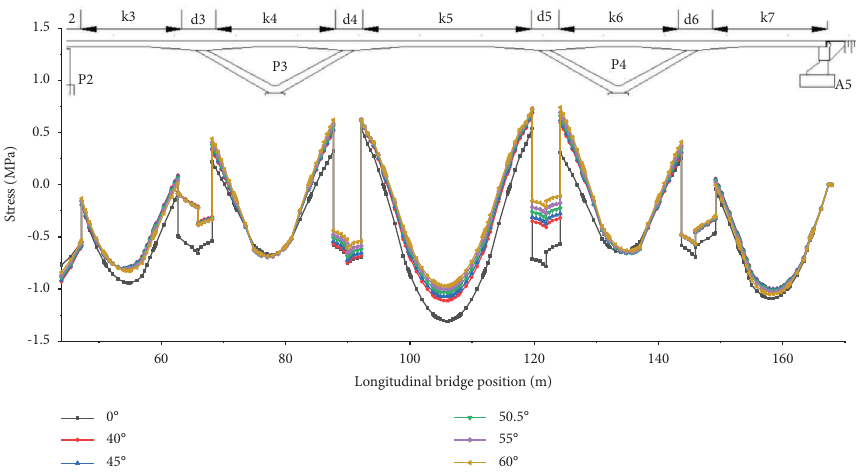
Figure 14: Comparison of stresses at the top edge of the deck slab.